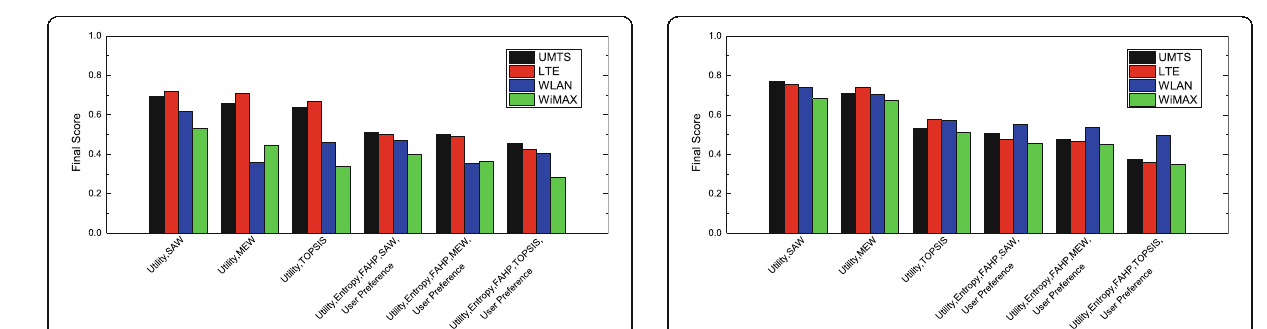
Fig. 12 Final scores of candidate networks for different algorithms for data